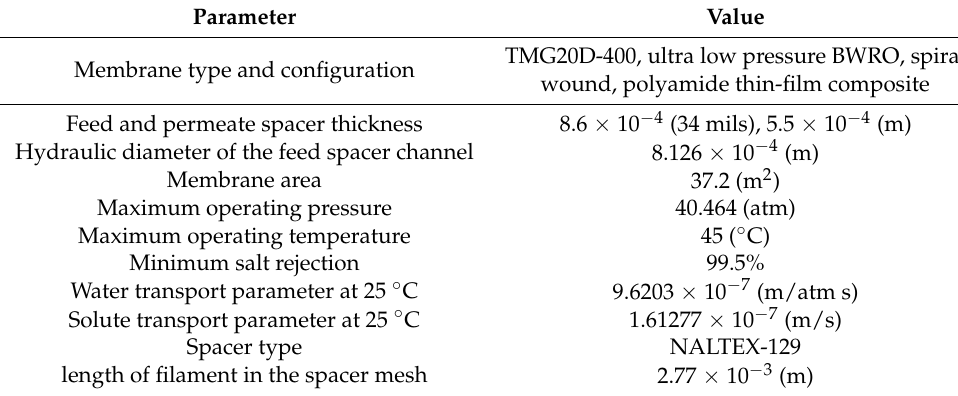
Table 1. Characteristics of the spiral wound membrane element and transport parameters